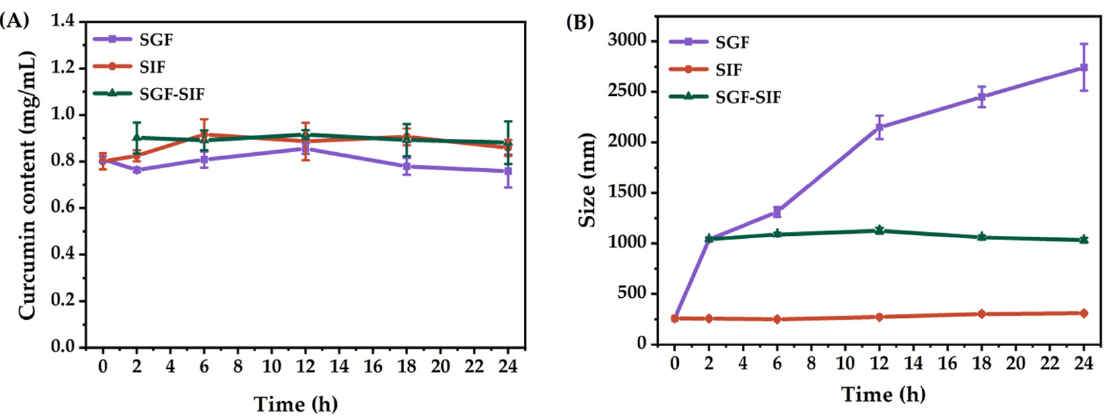
Figure 11. The variation of curcumin content ( A ) and mean droplet size ( B ) during in vitro gastrointestinal digestion for 24 h.